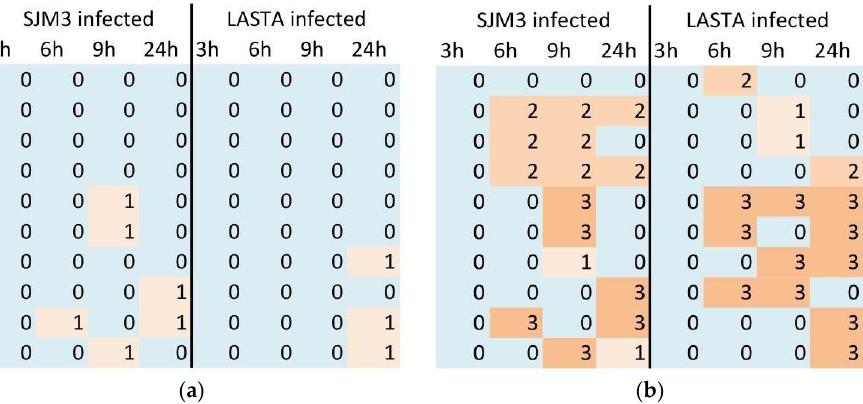
Figure 10. Phage resistance; 0 — no lysis zones, 1 — zone produced by 10 9 PFU/mL phage, 2 — zones